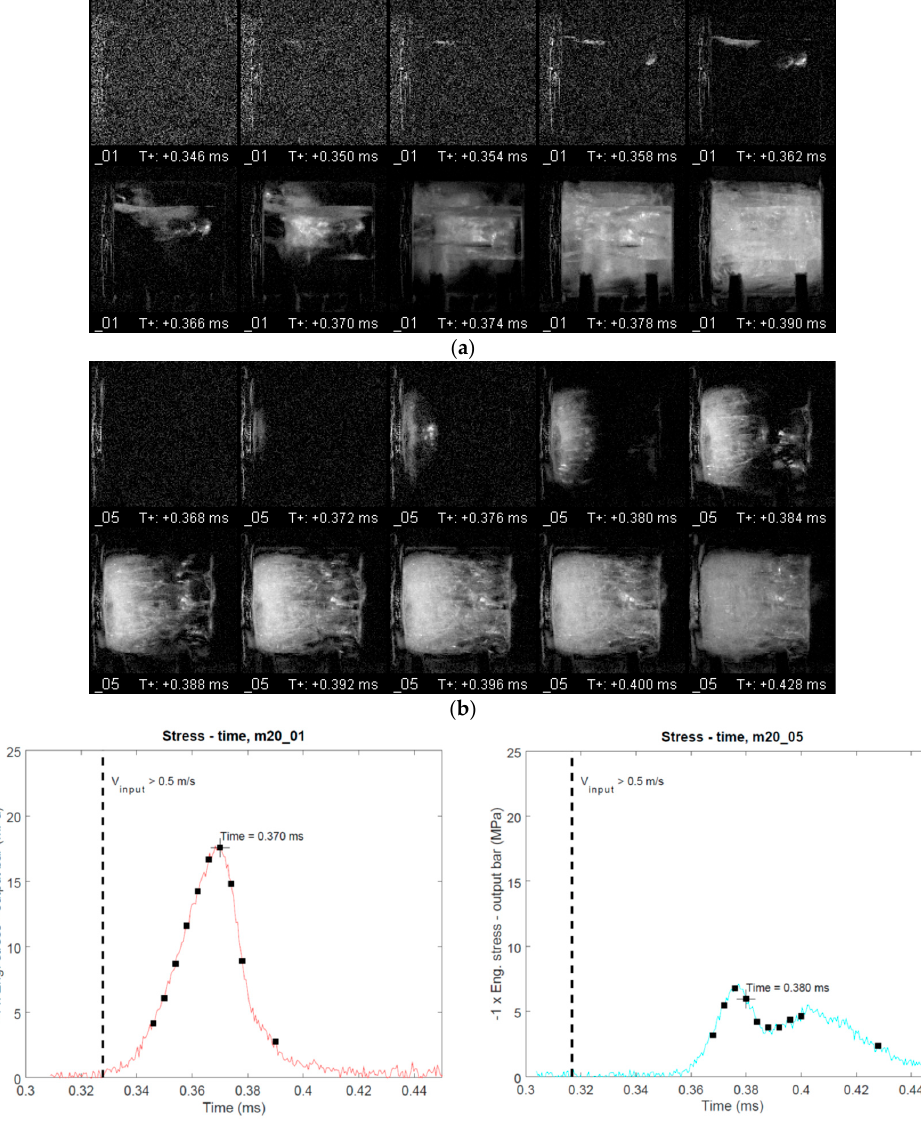
Figure 7. Processed high speed footage obtained in the high rate tests m20_01 ( a ) and m20_05 ( b ) alongside with the corresponding specimen stress–time signal ( c , d ) obtained from the output bar strain gauge measurement (synchronized with high speed footage). The input bar is located on the left-hand side of the figure in a and b . The time, at which the input bar end velocity exceeded 0.5 m/s as well as the times corresponding to the high speed frames are marked on the respective stress-time curves. The full videos are provided as supplementary material S1 and S2.